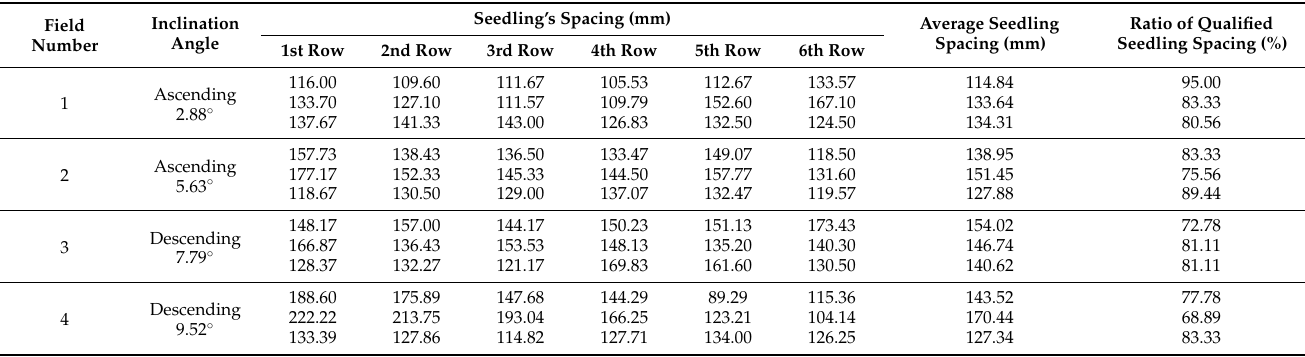
Table 6. Field experiment results of centralized metering device for